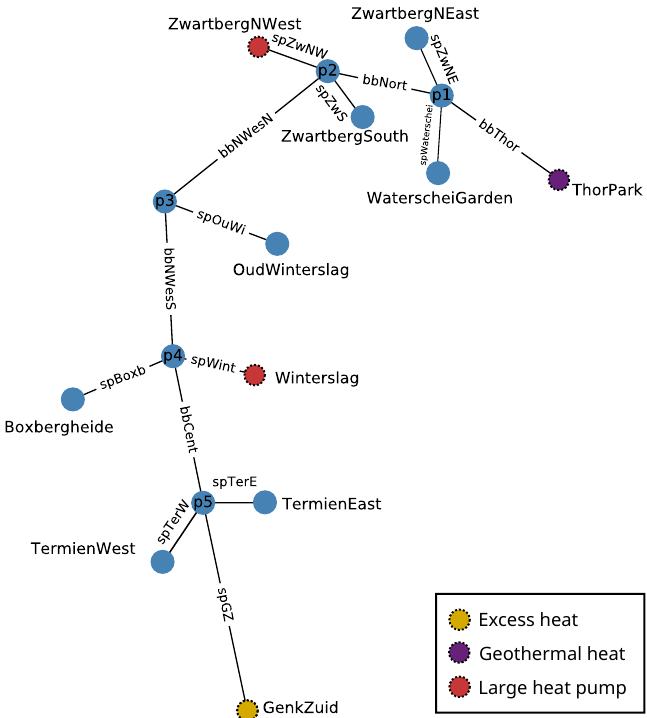
Figure 1. Network layout for the fictitious case study in Genk, Belgium. The heat demand of 9 neighbourhoods alongside a central backbone connection was aggregated per